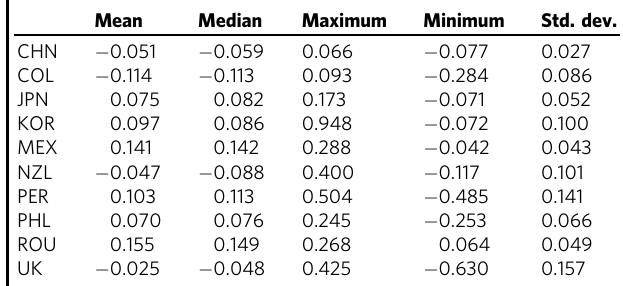
Table 9 Summary statistics for dynamic conditional correlations of